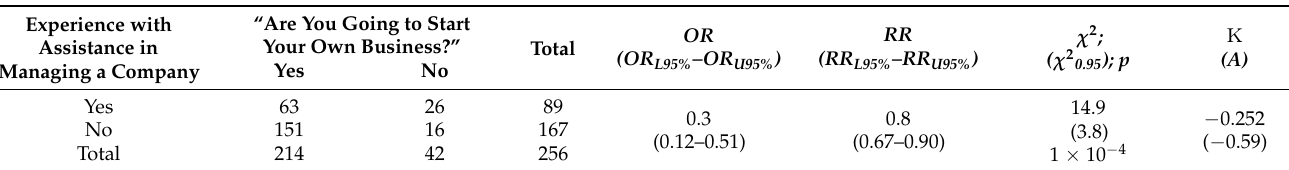
Table 4. Distribution of respondents’ answers within the framework to address the hypothesis that experience with company management has a positive effect on students’ intentions to start their own business.